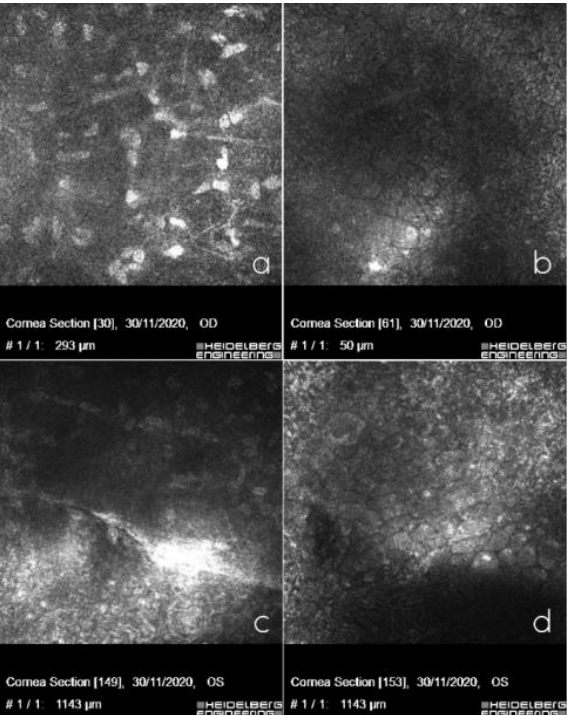
Figure 2. In vivo confocal microscopy showing posterior stromal keratocytes with elongated spindle- shaped nuclei in the right eye ( a ), polymorphism, polymegathism, giant endothelial cells with some nucleated cells in the right eye ( b ), curvilinear, hyperreflective banded lesion in the left eye surrounded by hyperreflective keratocytes ( c ) and hyporeflective vesicular lesions, in the form of a crater with hyperreflective deposits around the lesions in the left eye ( d ).